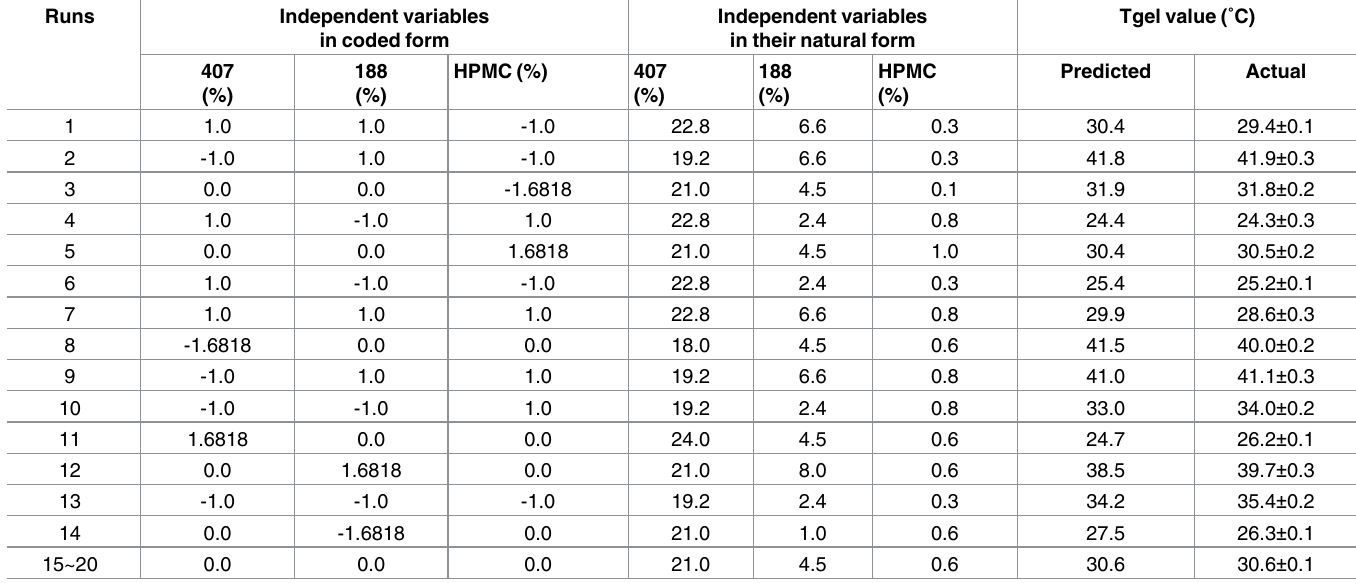
Table 4. Central composite design experiments and experimental